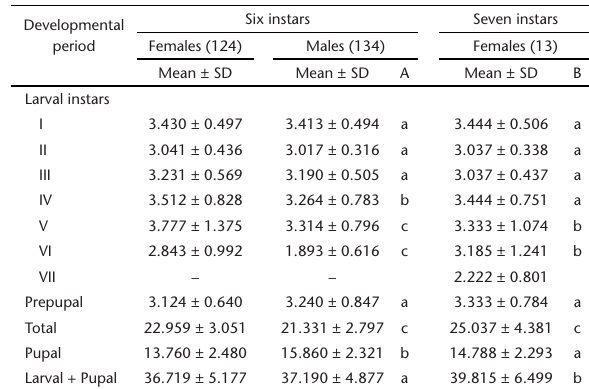
Table 2. Mean larval duration (days) of Spodoptera cosmioides , during each instar, including the larvae of each sex which developed for six and seven instars, fed with an artificial diet, under controlled conditions (25 ± 1°C, 70 ± 10% RH and 14 hour photophase). (A) Student t-test considering variances between means of females and males with six instars; (B) same but between females with six and seven instars.